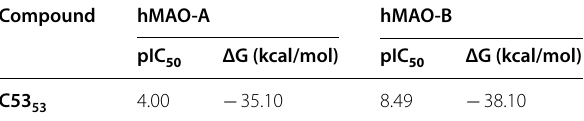
Table 2 Comparison between theoretical affinity and experimental inhibition data of C53